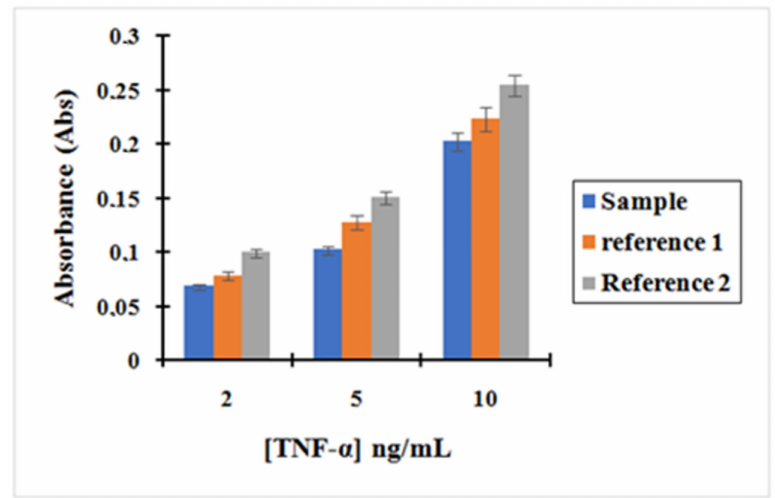
Figure 7. Bar graph showing (blue) the measurement of the absorbance after TNF- α incubation with the complex MNP@SiO 2 -NH 2 -CO-anti-TNF- α at three di ff erent concentrations of TNF- α : 2, 5, and 10 ng / L; (Orange) reference 1 represent the measurement of the absorbance of TNF- α after incubation with non-activated MNPs; (grey) Reference 2 represent the measurement of the absorbance of TNF- α after incubation with the initial